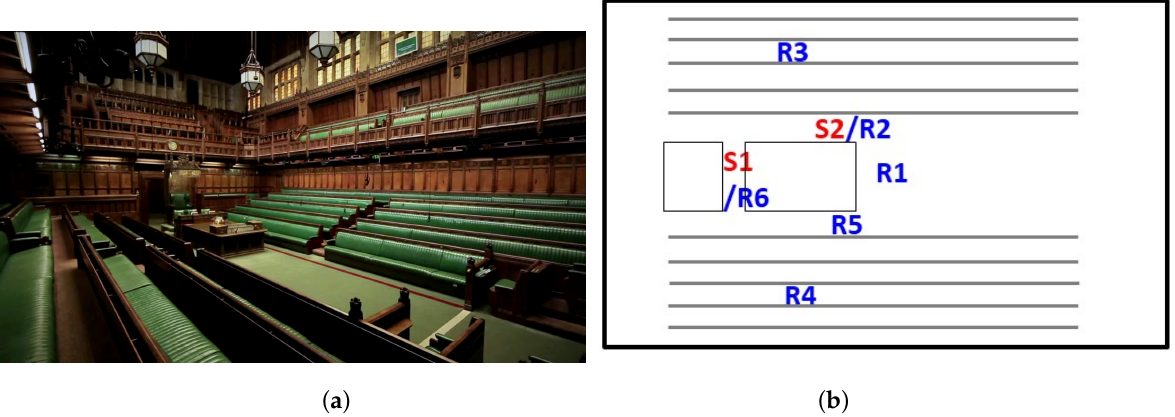
Figure 15. ( a ) Chamber of House of Commons, Palace of Westminster, in its current condition. Licence: CC BY-SA 3.0 via Wikimedia Commons [48] and ( b ) floor plan of the measured